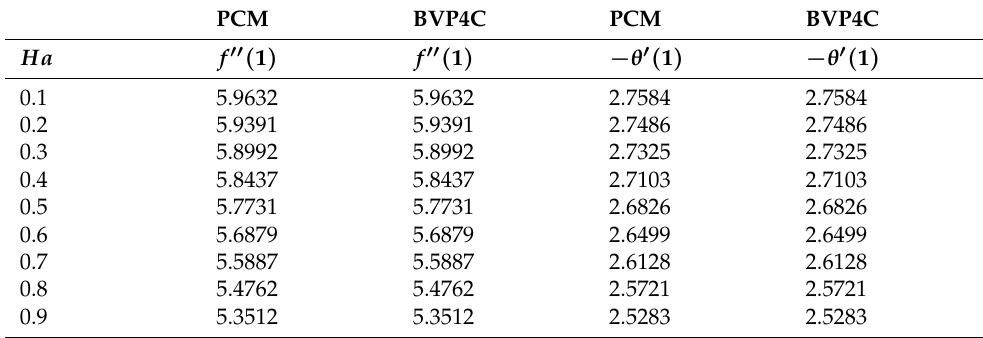
Table 5. Comparison of the numerical results by two methods PCM and BVP4C for skin friction and Nusselt number, with various physical parameters and Φ 1 = Φ 2 = 0.1.